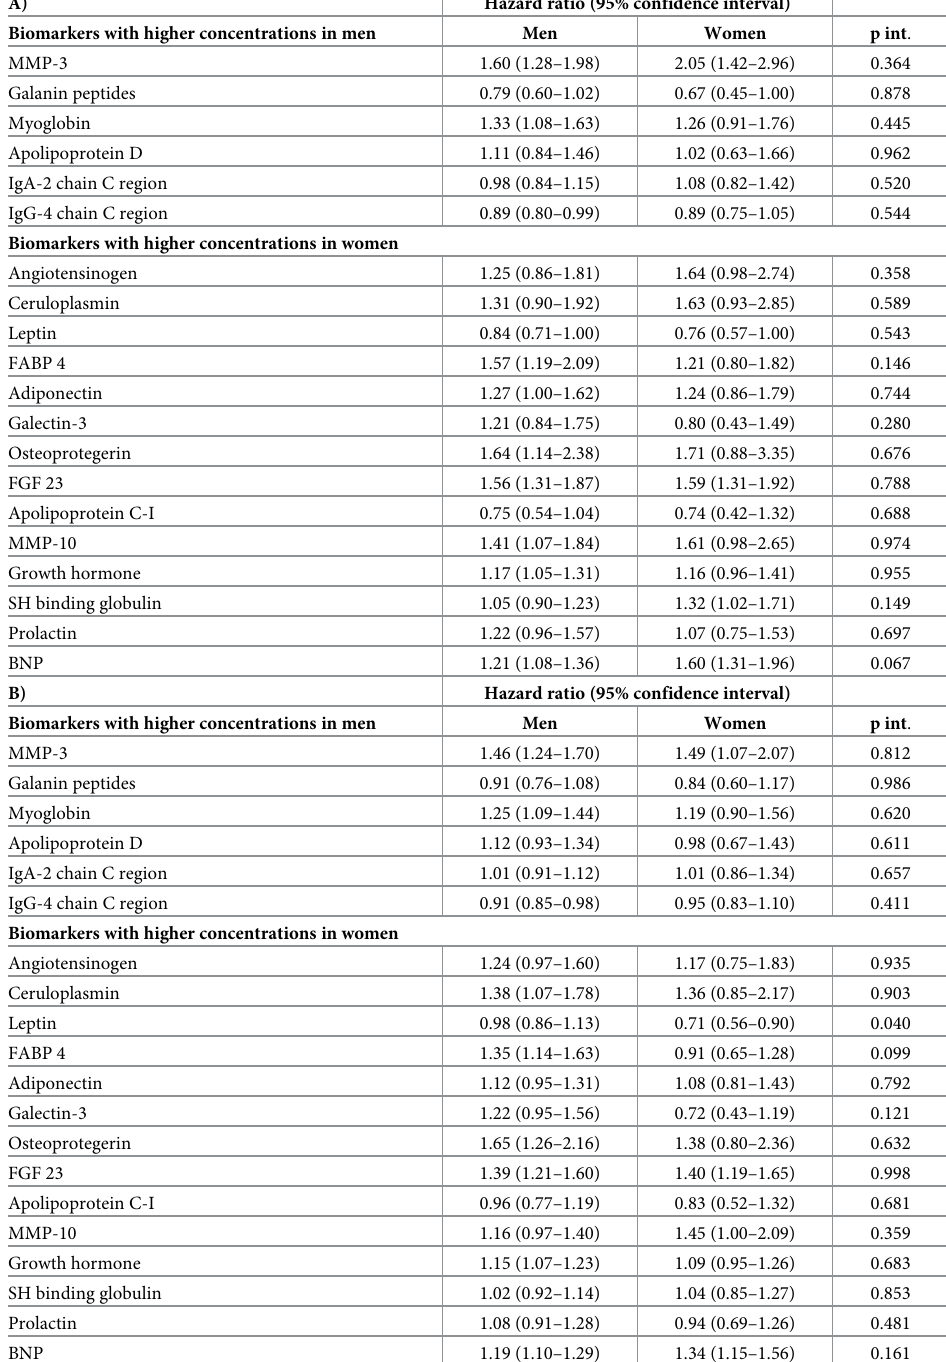
Table 3. Associations of biomarker concentrations with outcome. A) All-cause mortality; B) Major adverse